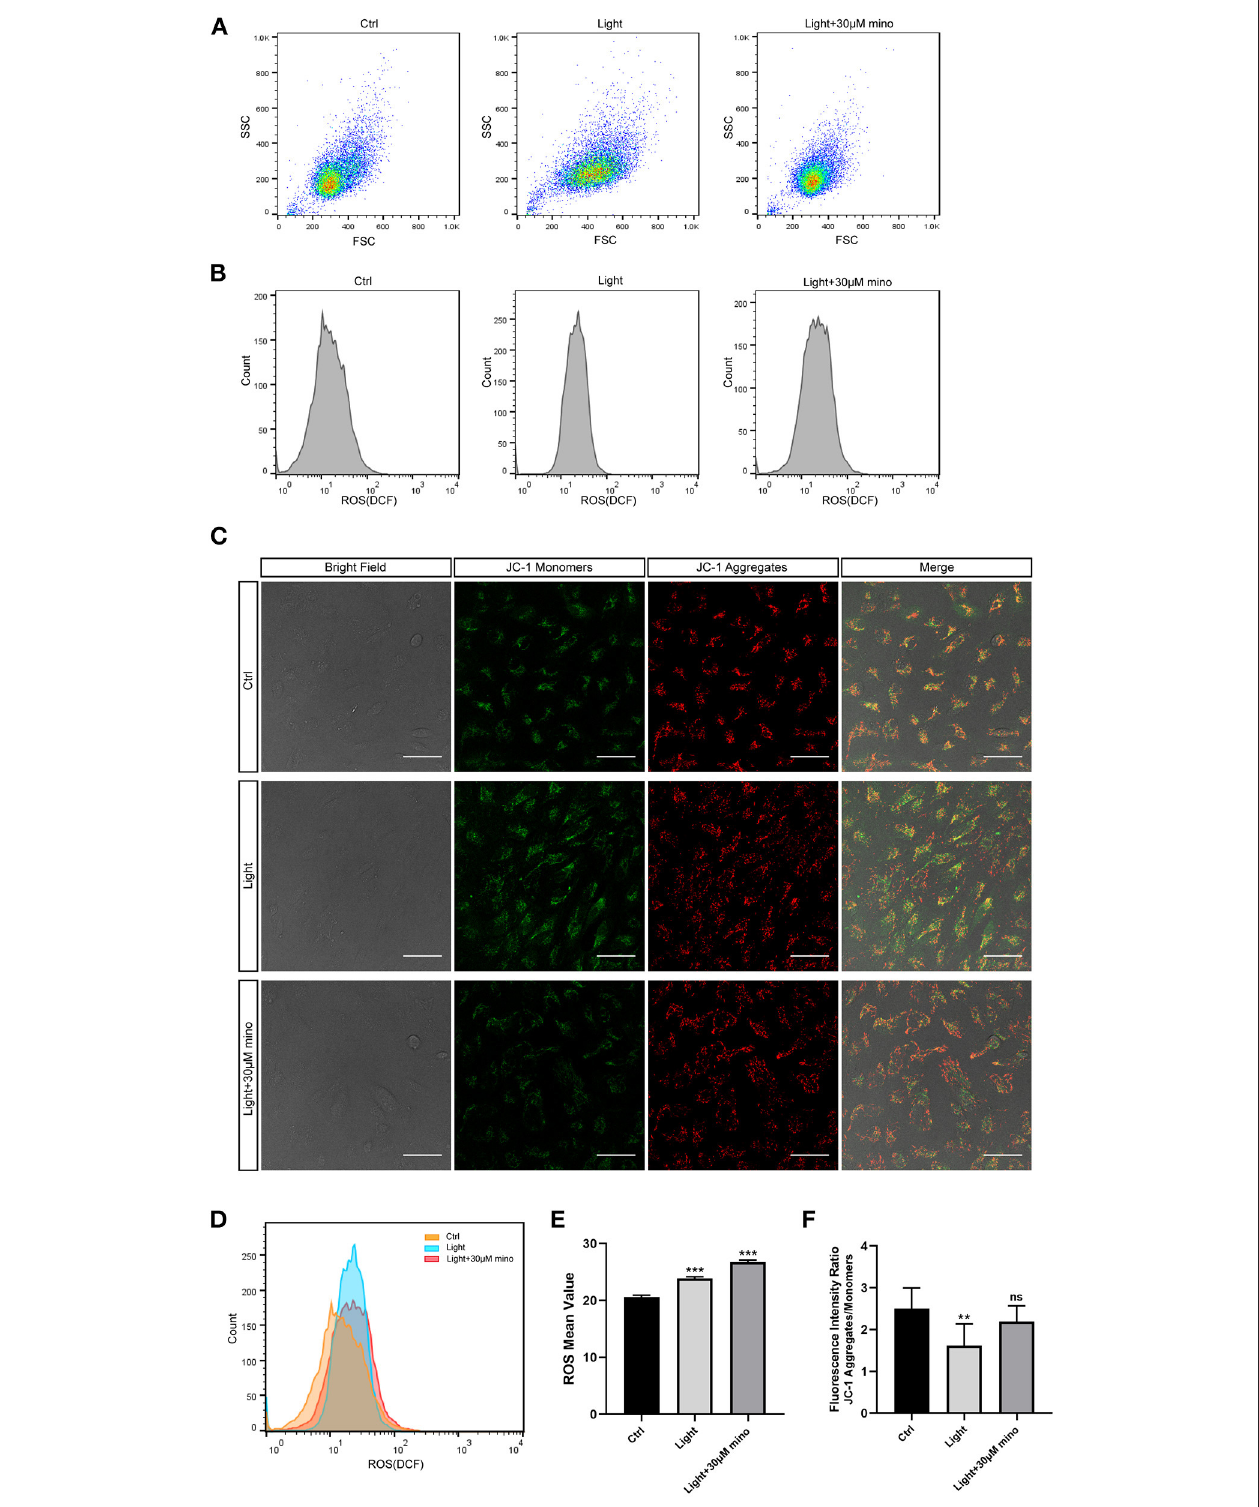
FIGURE 6 | Mechanisms by which minocycline reduces light-induced RPE death. (A) Variations in FSCs and SSCs in ARPE-19 cells in different groups in ROS experiment. Blue light exposure time was 30min. In blue light group, cell mass became elliptical, and FSC value moved right. In blue light with minocycline group, ARPE-19 cells were preincubated with 30 µ M minocycline for 30min before blue light exposure, and cell mass was aggregated and similar to that of control group. (B) ROS of ARPE-19 cells in different groups. Blue light exposure time was 30min. (C) Bright field and JC-1 fluorescence images of different groups. Blue